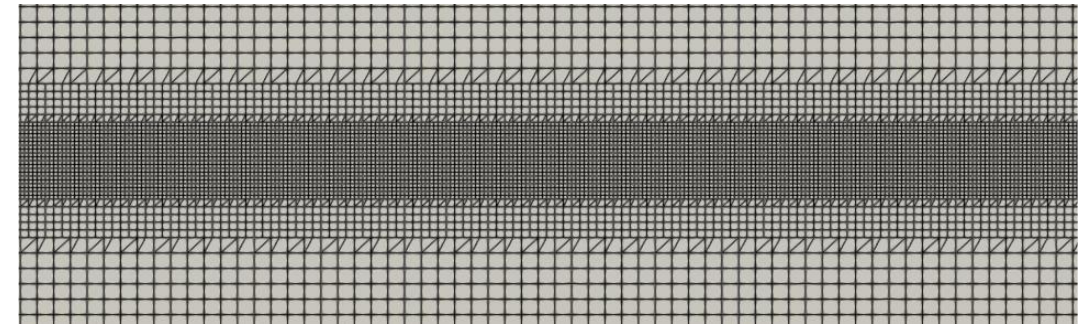
Figure 8. Refinement at the free surface in 2D CFD numerical wave